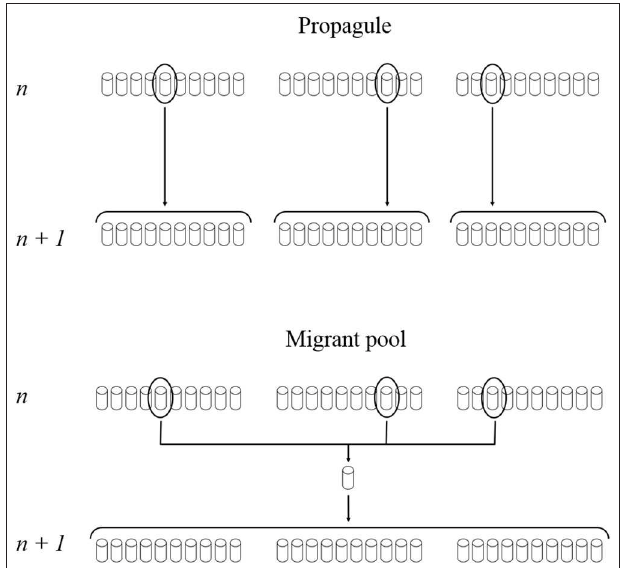
FIGURE 1 | Reproduction methods. Propagule method corresponded to the selection of one parental community among ten at cycle n and the creation of ten new communities from this parental unit at cycle n + 1 . This protocol was repeated independently three times ( n = 30, three distinct lines). Migrant pool method corresponded to the selection of three parental communities among thirty (one among ten, three times, to have a constant selection rate between the two reproduction methods; n = 30, one line). The three parental units were mixed and used to create thirty new communities at cycle n + 1 . The experiment ran over 14